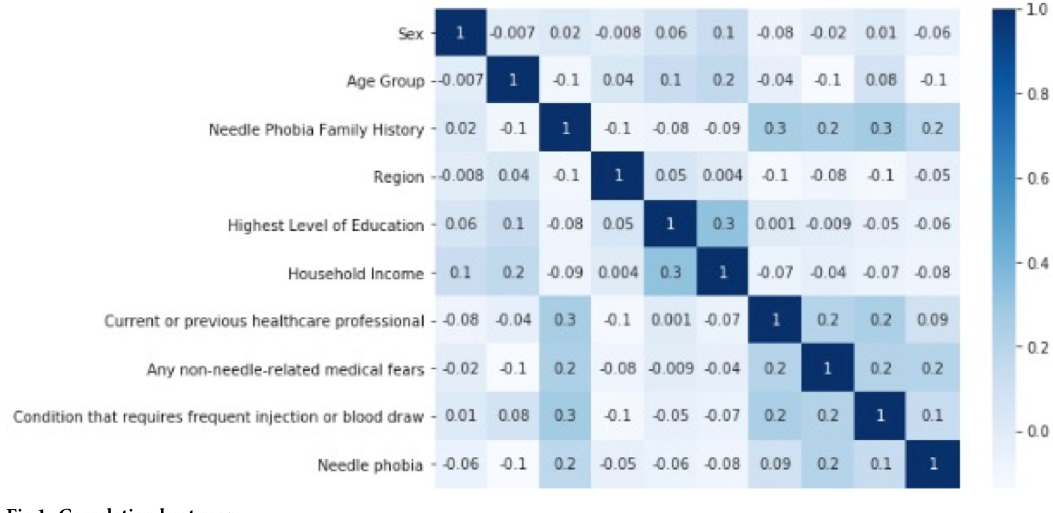
Fig 1. Correlation heat